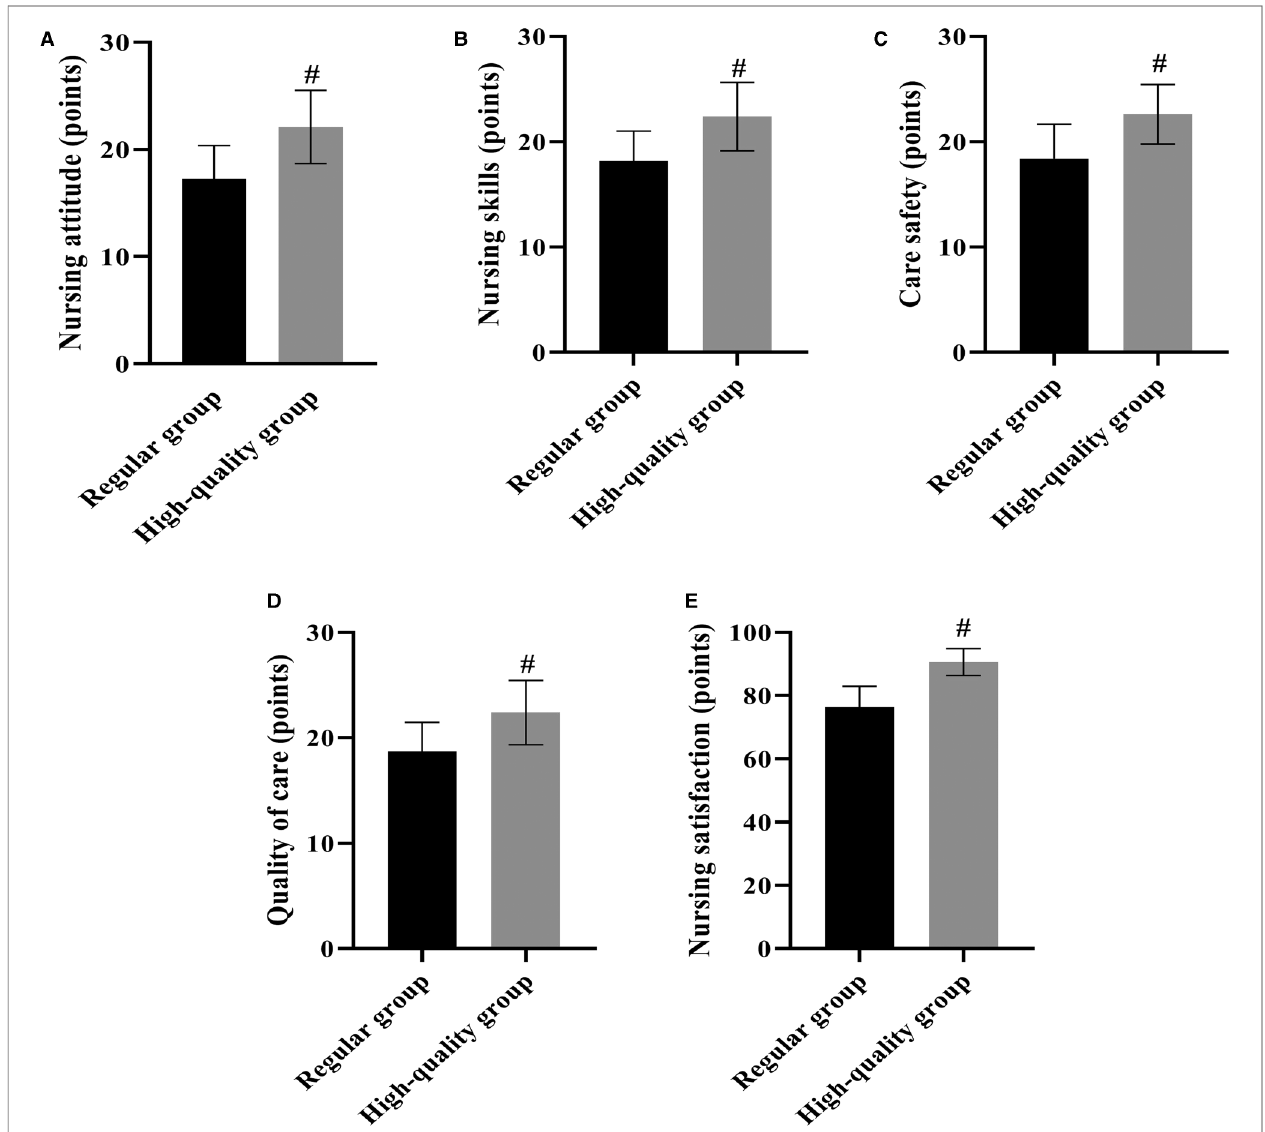
FIGURE 2 | Comparison of various scores of nursing satisfaction after care in the two groups (Mean, SD). Note: ( A ) shows nursing attitude scores, ( B ) shows nursing skill scores, ( C ) shows nursing safety scores, ( D ) shows quality of care scores, and E shows total nursing satisfaction scores. # shows the difference with the Regular group, p